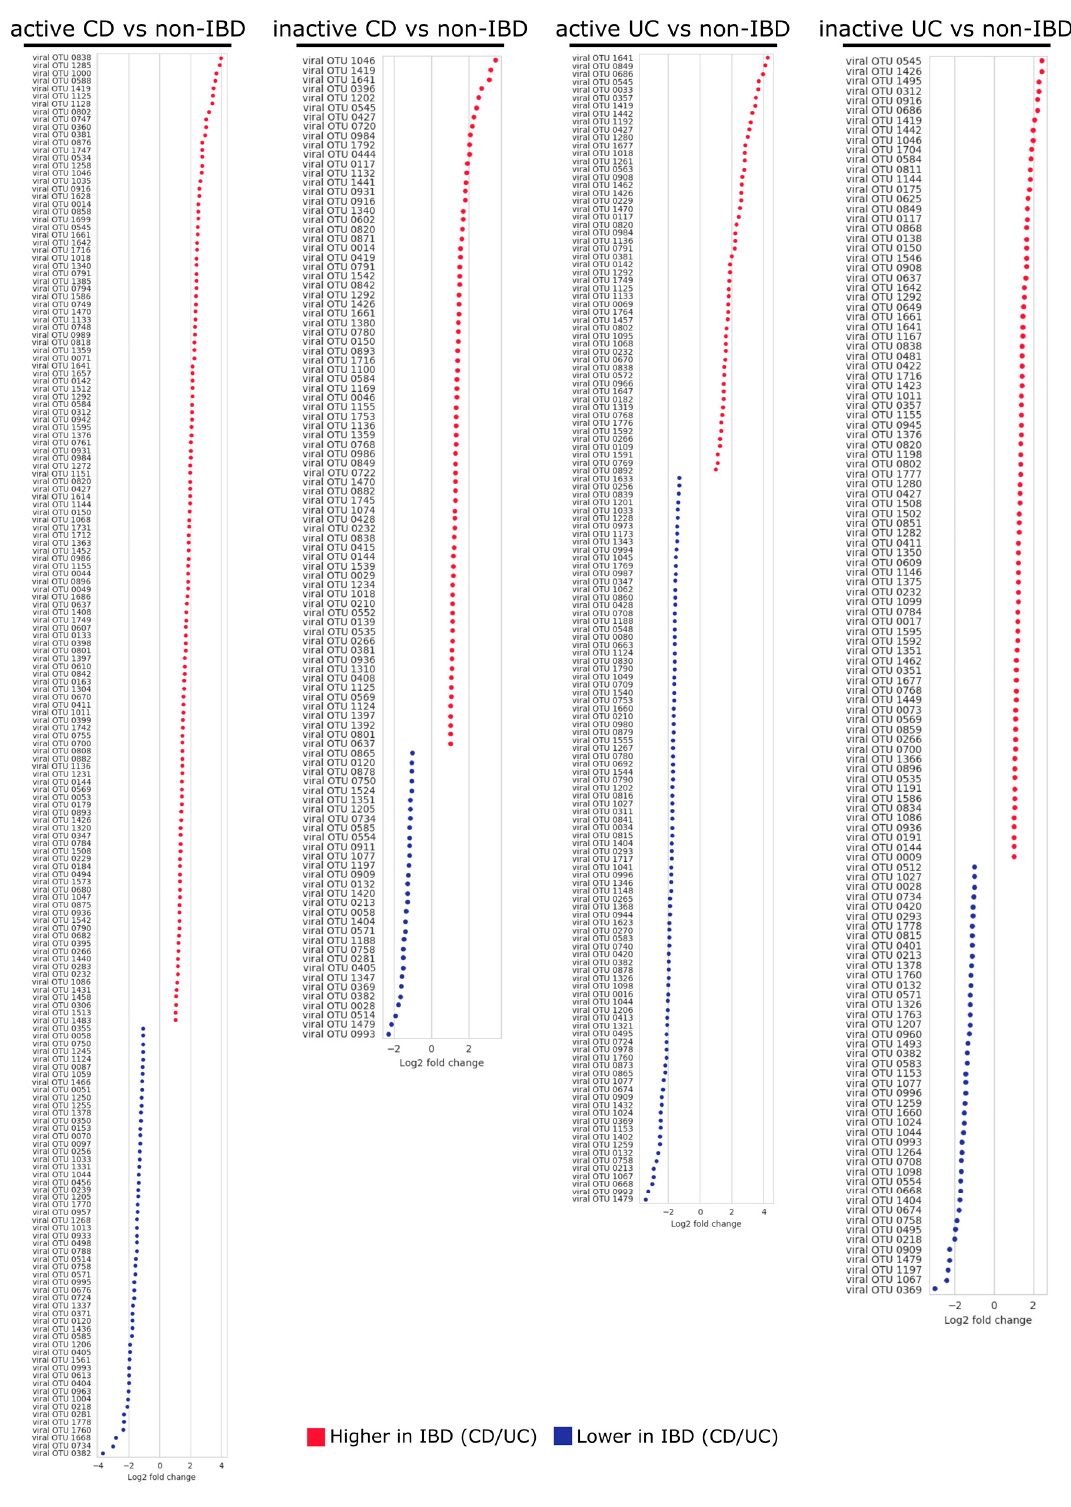
Figure 5. Log 2 fold-change values for temperate bacteriophages displaying statistically significant differences in abundance between IBD and non-IBD patients (FDR < 0.1). Positive fold-change values indicate a higher abundance in IBD patients, whereas a negative fold-change indicates higher abundance in non-IBD patients. The following samples were used: 87 active CD samples from 24 patients, 448 inactive CD samples from 48 patients, 29 active UC samples from 9 patients, 298 inactive UC samples from 29 patients, and 362 non-IBD samples from 26 patients.